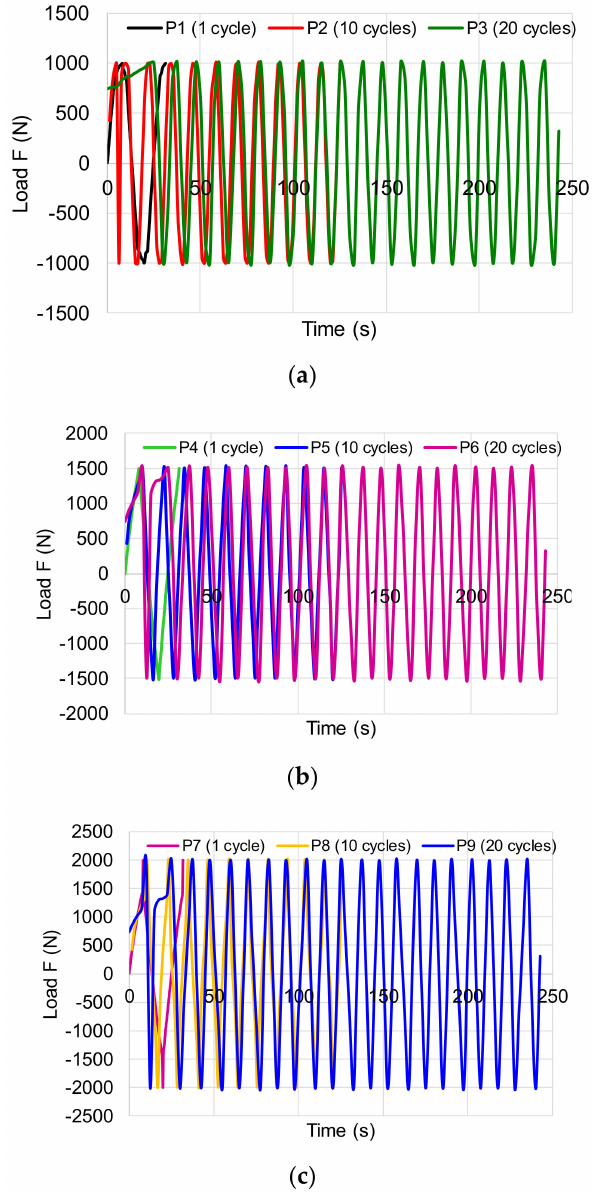
Figure 3. Variation of symmetric cyclic loading to tensile-compression: ( a ) ± 1000 N; ( b ) ± 1500 N; ( c ) ± 2000